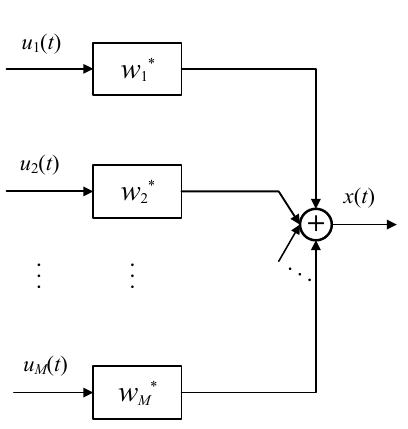
Figure 6. A general beamformer.